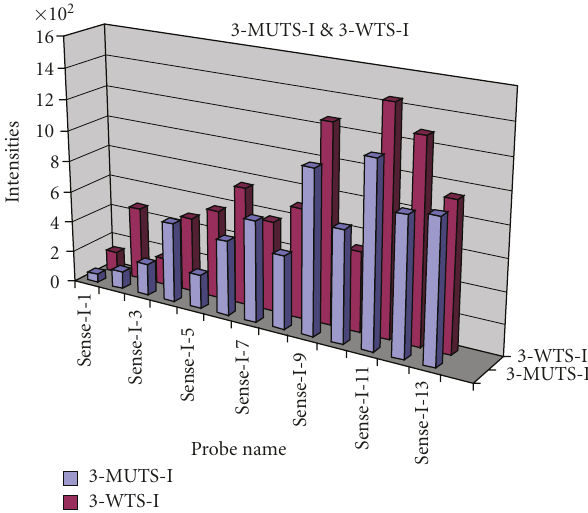
Figure 10: Data analysis results of mutation 3 (sense strand), by the emulated architecture for wild type